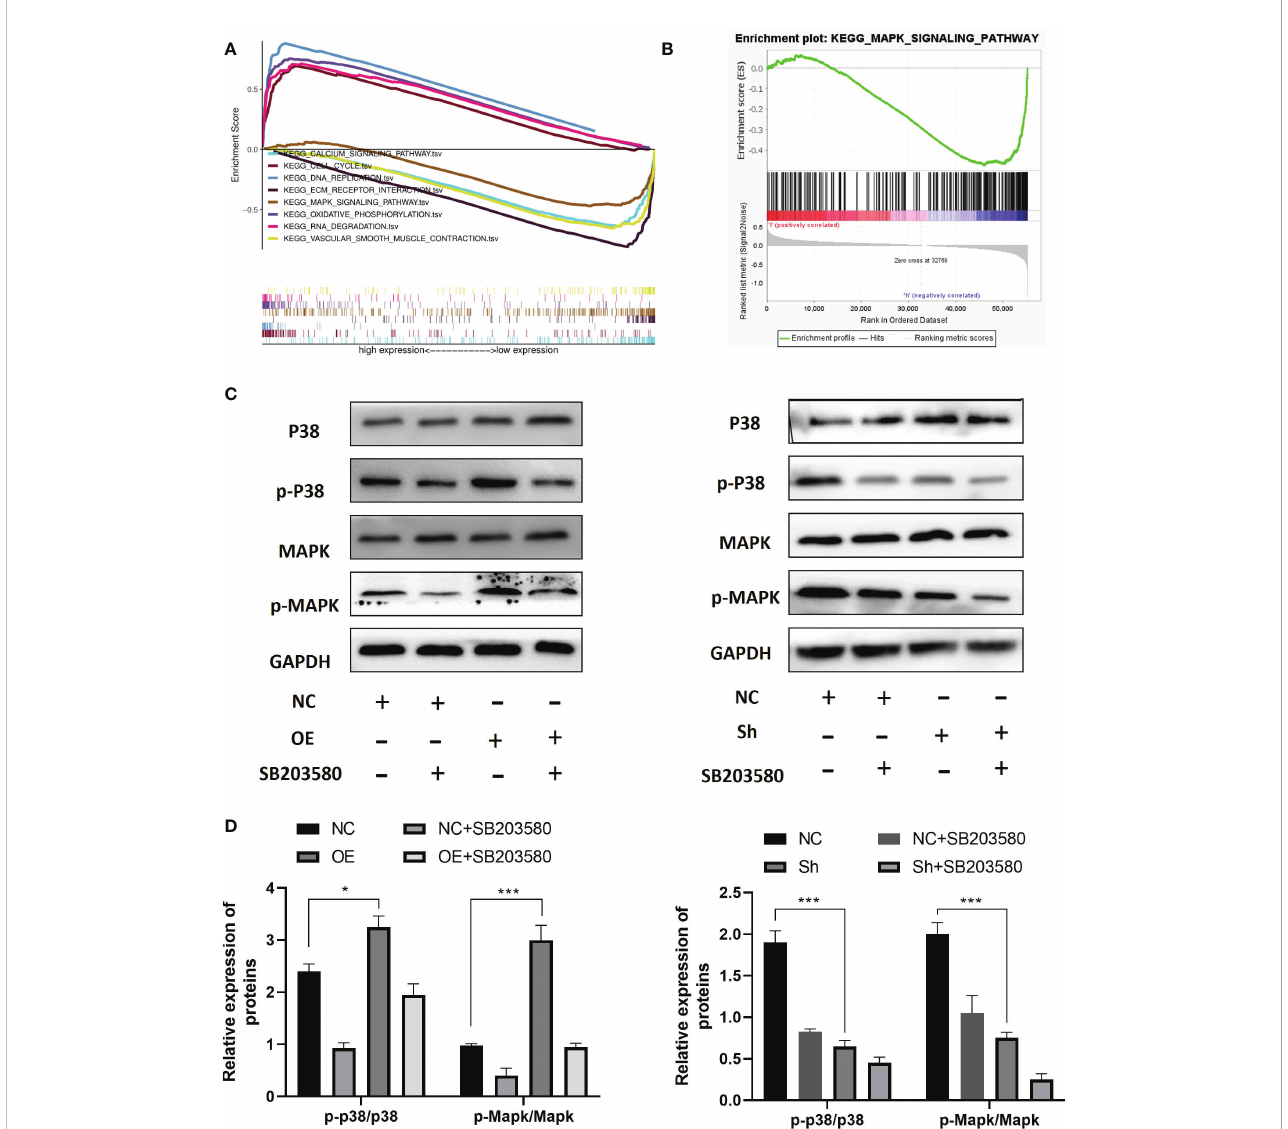
FIGURE 4 RPS6KA2 inhibited development of ovarian cancer cell via the MAKP pathway. (A, B) GSEA analysis showed the relevance between MAKP signaling pathway and RPS6KA2. (C, D) The protein expression levels of p-p38/p38 and MAPK/p-MAPK in OVCAR3 and SKOV3 cells. (* indicates p<0.05, *** indicates